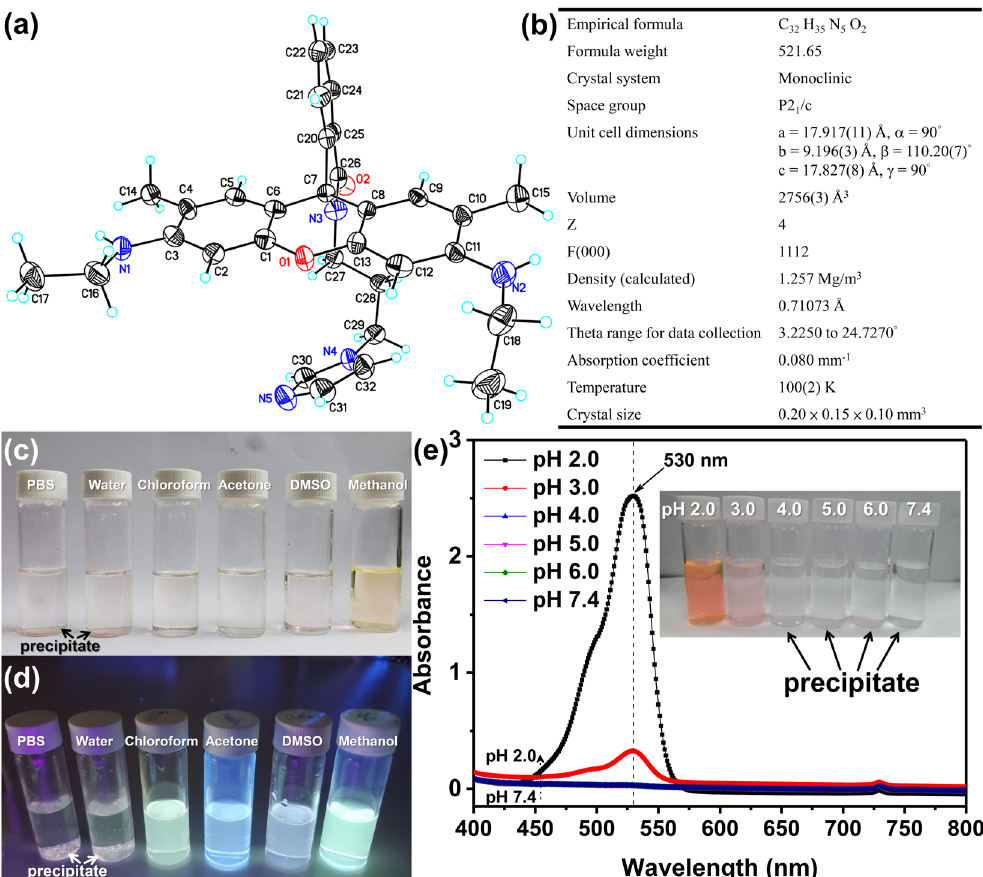
Figure 1. ( a ) Single crystal structure of I-R6G determined using single-crystal X-ray diffraction. ( b ) Crystallographic data and structure refinement details for the crystal structure of I-R6G. Photographs of I-R6G in various solvents at 25 °C under ( c ) natural light and ( d ) long-wavelength UV lamp illumination. ( e ) UV-Vis spectra of I-R6G in aqueous solutions with pH values of 2.0–7.4 at 25 °C. The inset photograph shows the solubility of I-R6G in aqueous solutions with different pH values.